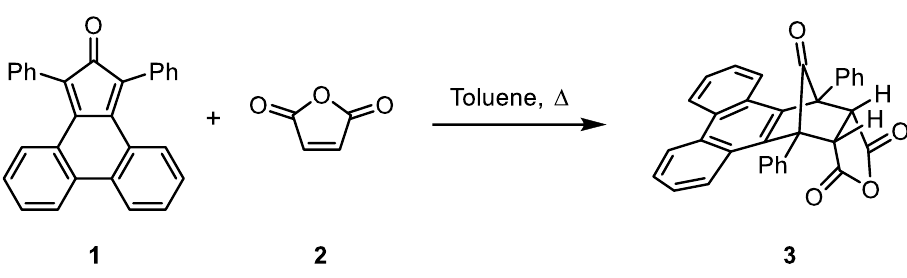
Scheme 2. Reaction of compound 3 with 2-methoxyaniline ( 4 ) to form maleimide 5